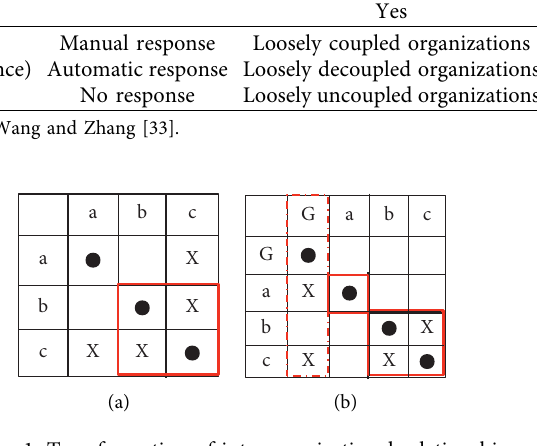
Figure 1: Transformation of interorganizational relationship.